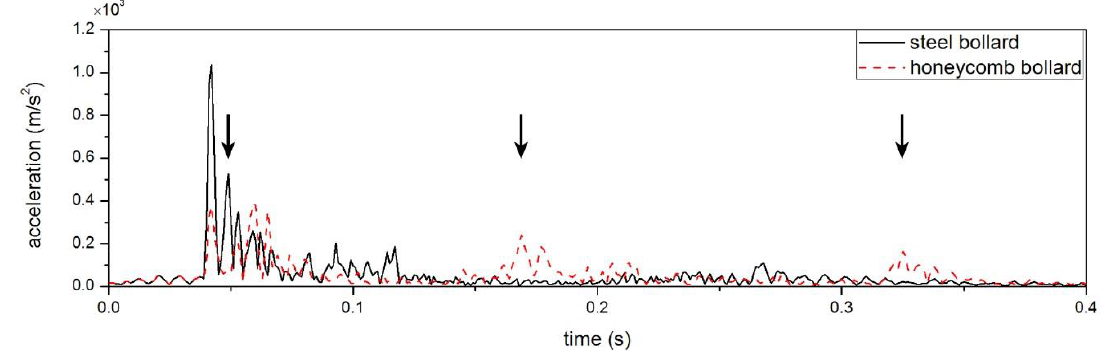
Figure 8. Simulated acceleration evolutions at the front bumper frame: arrows indicate the estimated three local acceleration peaks of honeycomb bollard.